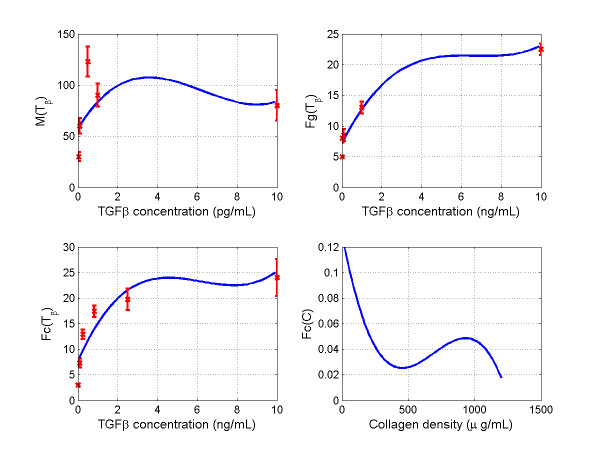
Macrophage migration rate M(Tβ) [17], fibroblast growth rate Fg(Tβ) [17], and fibroblast secretion rate Fc(Tβ) [23,41]plotted as functions of TGF-β1 concentration. The original experimental data (x, Mean ± SD) are shown for comparison. The function Fc(C) was provided by Waugh et al [27,28].